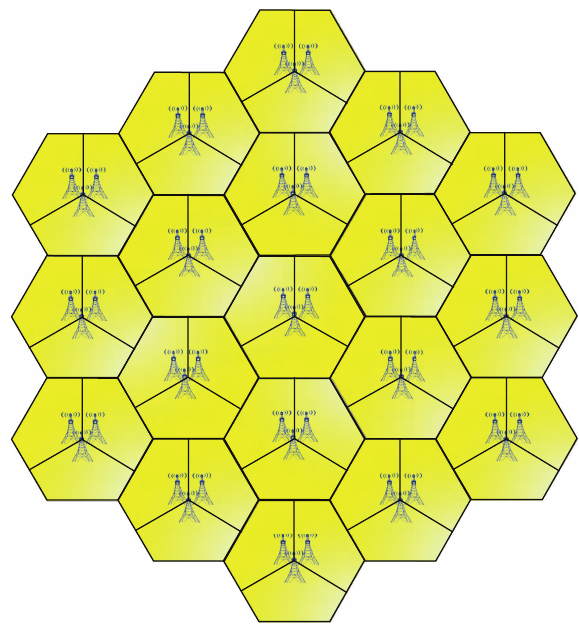
Figure 7: 19 cells’ topological structure.